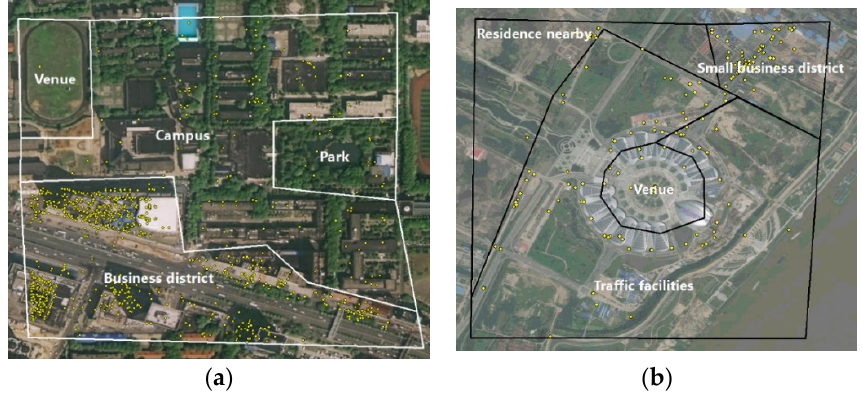
Figure 5. POIs in the neighboring area of: ( a ) the gate of a university; ( b ) a newly built venue.